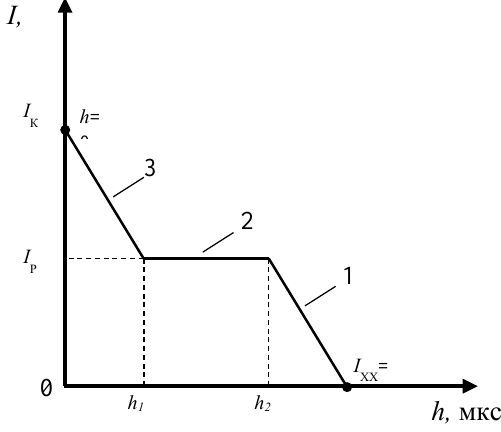
Fig. 1. Dependence of current (I) on the value of IEG (h)